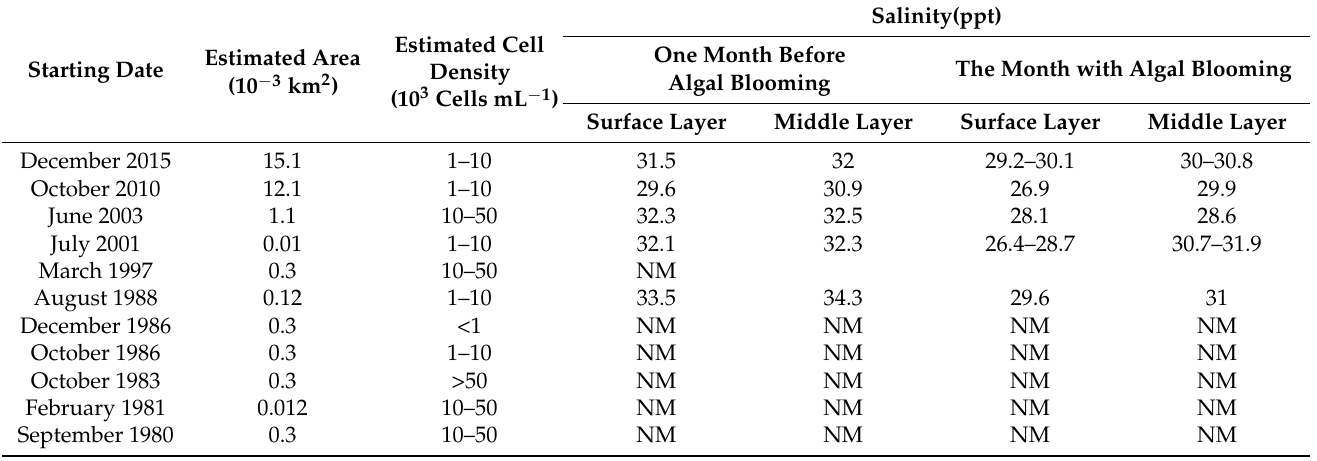
Table A1. Summary of growth rates and maximum cell densities of K. mikimotoi obtained in the present study and previously reported. NM: not measured by EPD database.